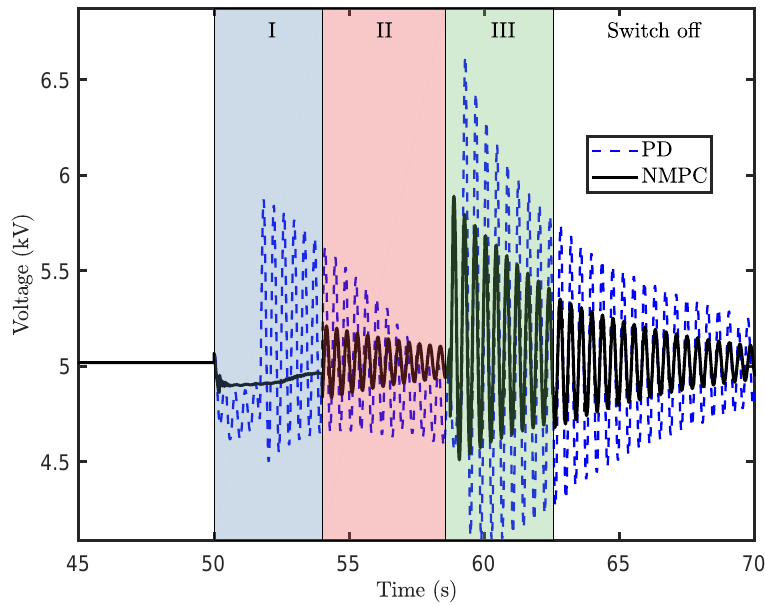
Figure 11. The field voltage, γ = 0.5, mean wind speed 0 m/s, TI = 0.